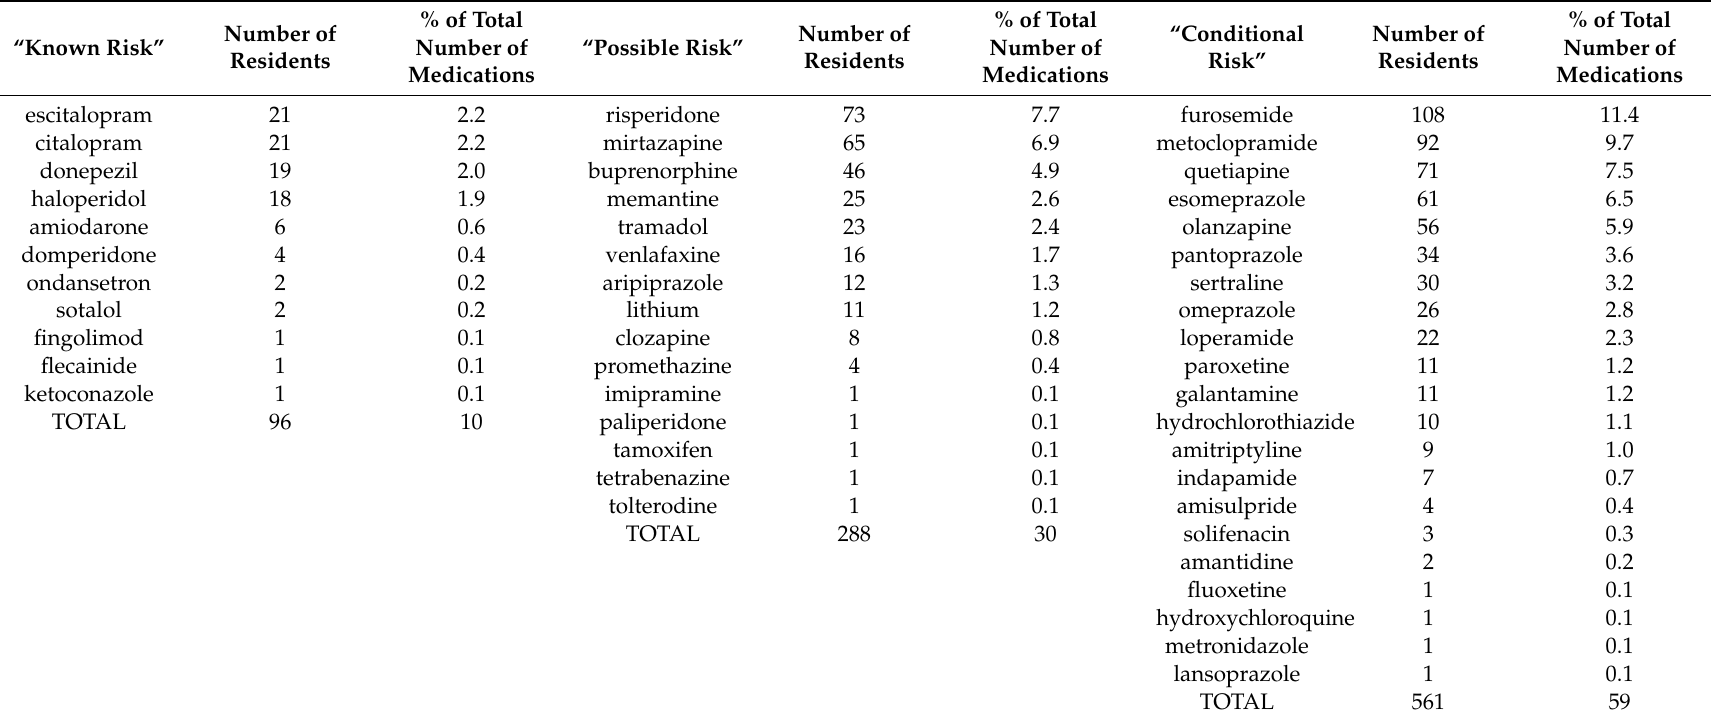
Table 3. Use of QT-prolonging